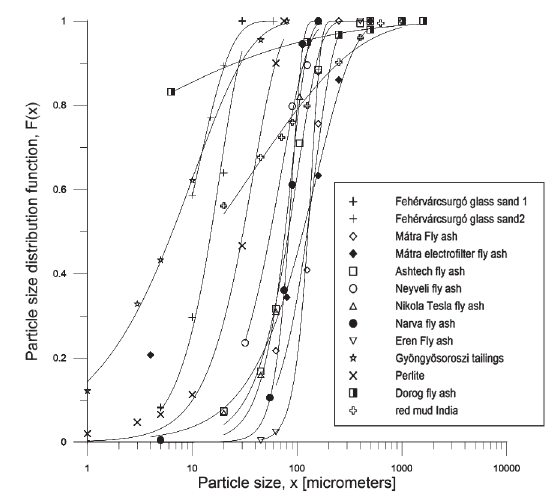
Fig. 2. Measured particle size distributions of most of the tested bulks